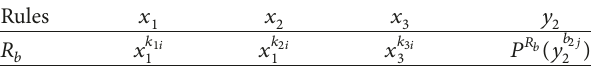
Figure 1: T-S fuzzy fault tree. Table 1: Rules for T-S gate 𝑏